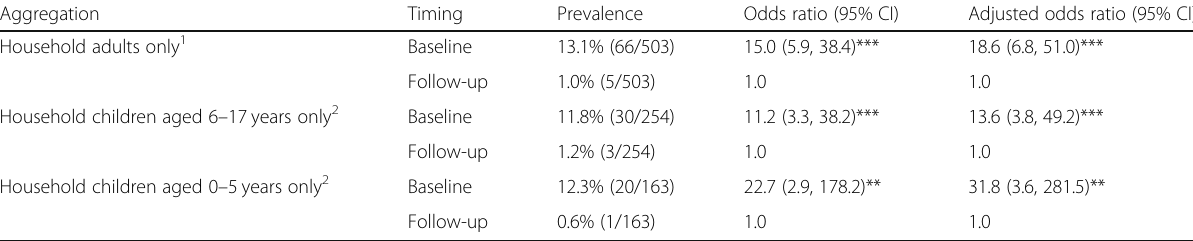
Table 3 Diarrhea prevalence by age group at baseline and follow-up Aggregation Timing